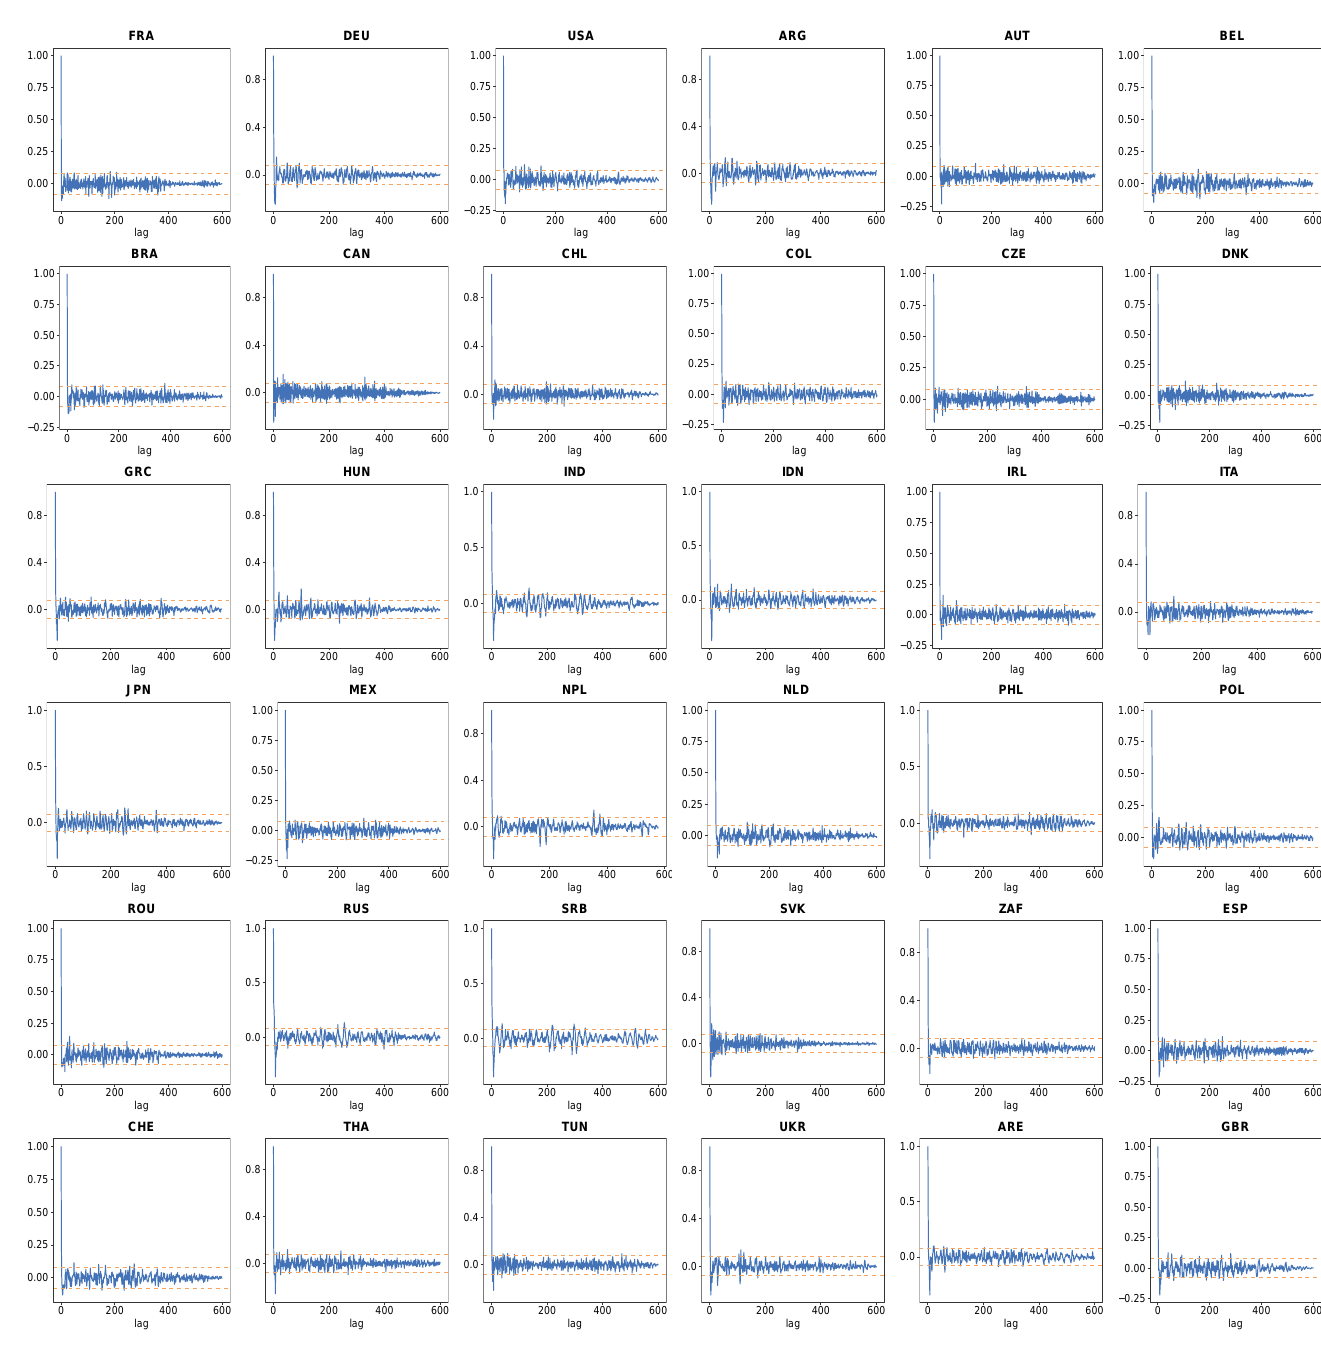
Figure A5. Autocorrelation of the normalized error ε t using the R-software functionalities (acf() function) for 36 countries. The dotted lines give the 95% confidence interval for